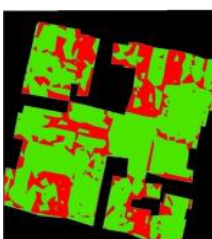
Fig.7 classification result. Red: debris class. Green: intact building